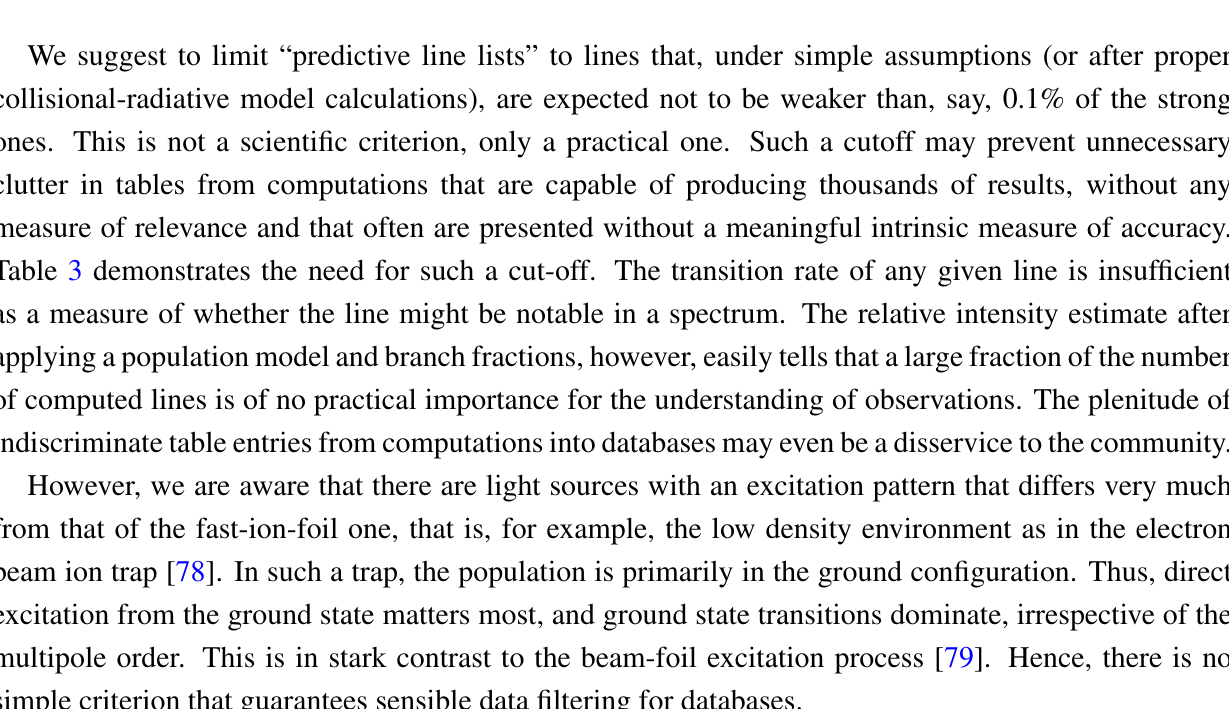
Table 1. Energy levels of the n = 2, 3 and 4 shells of Na VII. E